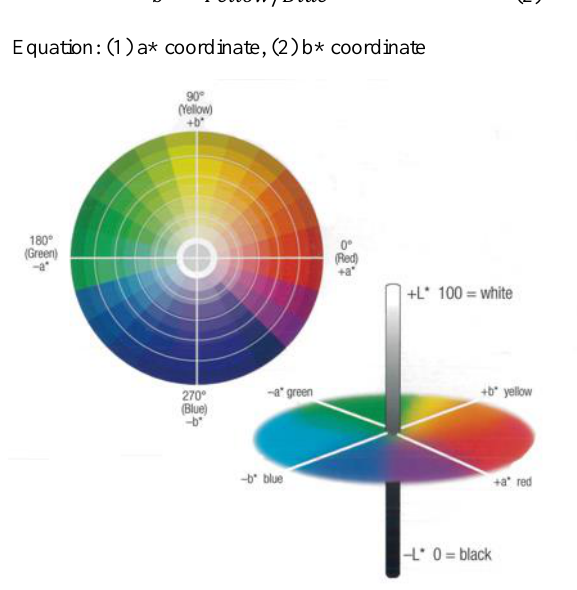
Figure 1. CIELAB Color Space (adopted from www.Bonlalum.com)